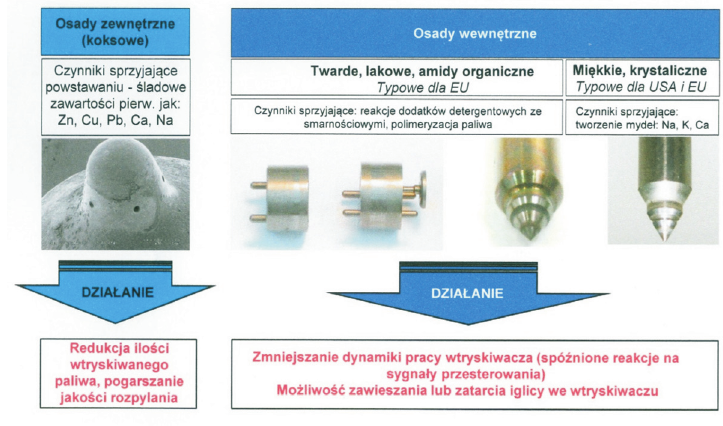
Fig. 2. Types of deposits formed inside and outside of the injectors in HPCR injection systems, factors facilitating their formation and impact on engine operation